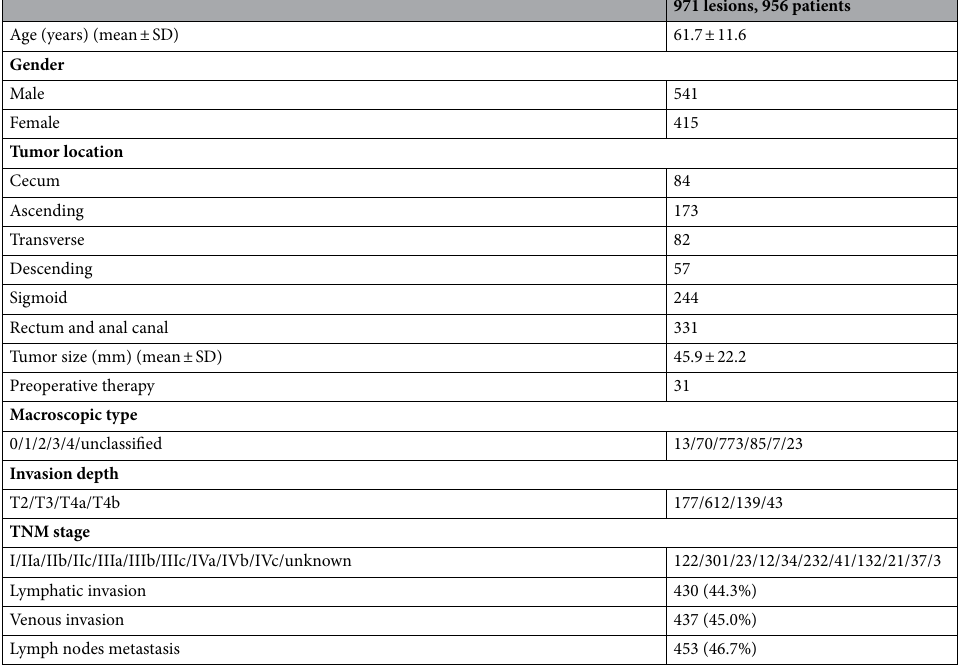
Table 1. Clinicopathological characteristics of CRC samples. SD standard deviation, T2 tumor invades the muscularis propria, T3 tumor invades through the muscularis propria into the pericolorectal tissues, T4a tumor invades through the visceral peritoneum (including gross perforation of the bowel through tumor and continuous invasion of tumor through areas of inflammation to the surface of the visceral peritoneum), T4b tumor directly invades or adheres to other adjacent organs or structures. Synchronous cancer was counted as one cancer at TNM stage, lymph node metastasis, and distant metastasis. The TNM stage of the three cases was unknown because there was no information on lymph node metastasis in local